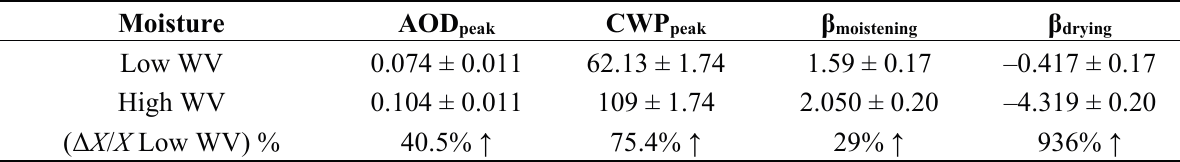
Figure 8. Response of cloud water path (CWP) to increasing aerosol optical depth (AOD) in low and high atmospheric WV environments for NAADR_Marine. Table 2. Comparative table of the percent increase ( ↑ ) in the characteristics parameters of cloud water path response curve to aerosol induced perturbation from low to high water vapor environment for NAADR_Marine.